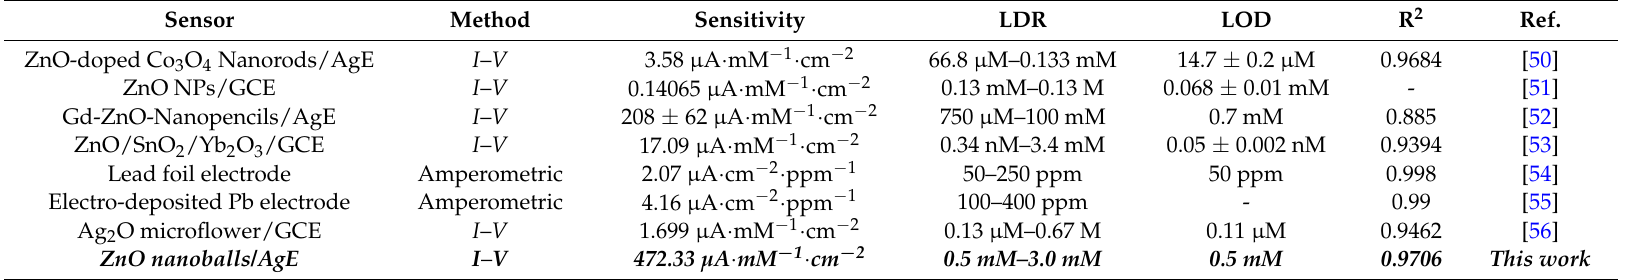
Table 2. Summary of the acetone sensing performances of different sensor